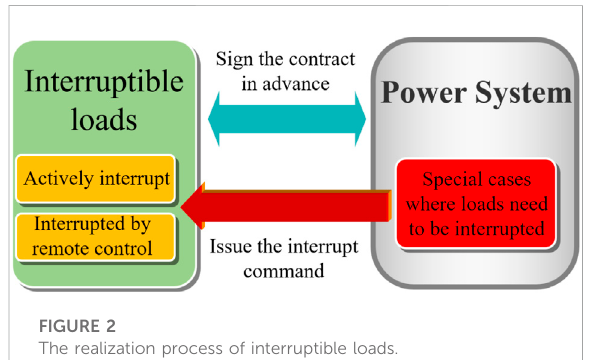
FIGURE 2 The realization process of interruptible loads.